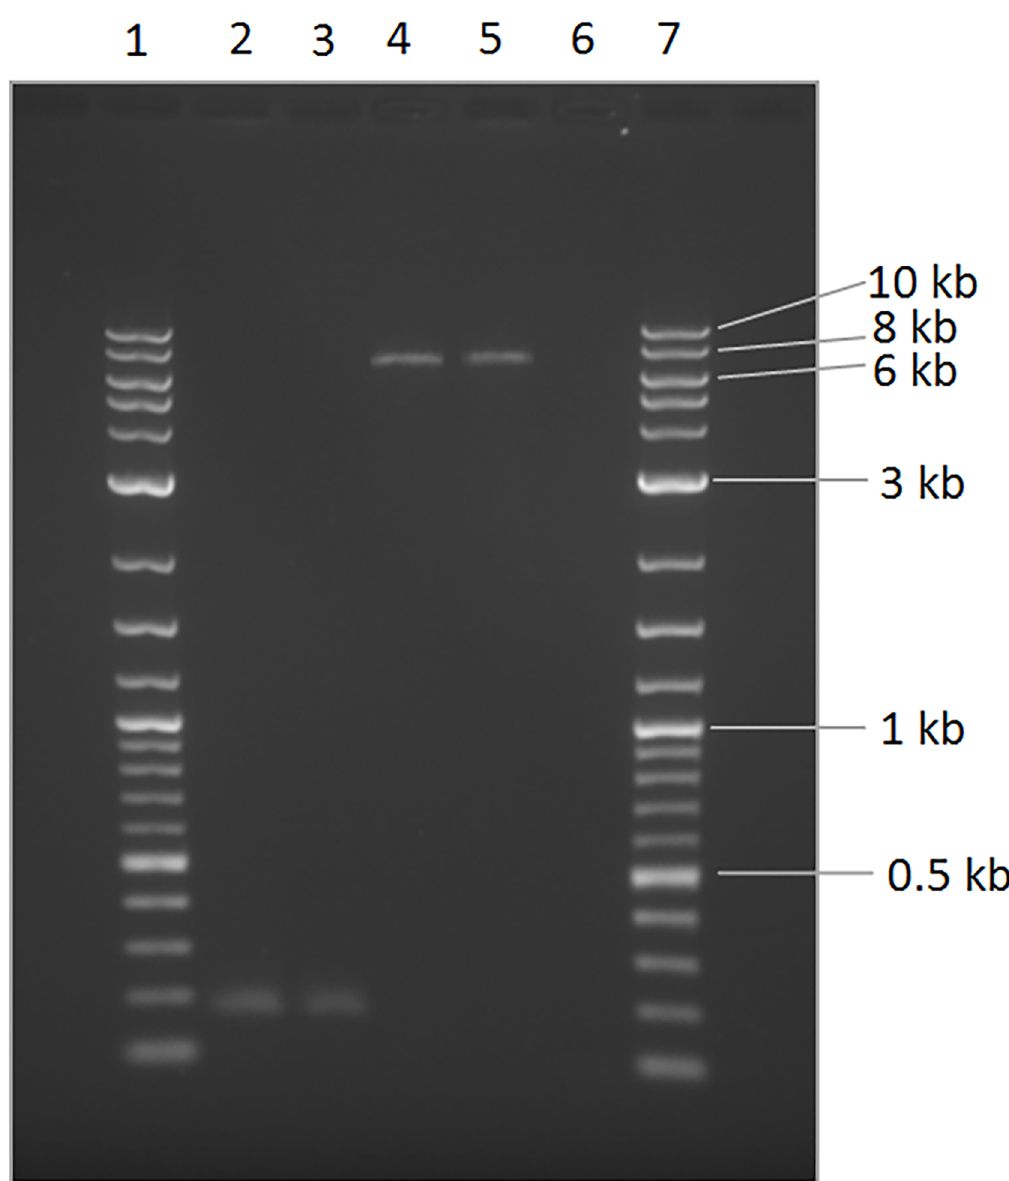
Fig 2. Agarose gel electrophoresis analysis of PCR amplification of the LINE-1 insertion in UK Swedish Vallhund retinopathy cases and controls. Lanes1 and 7 are a 2-Log DNA ladder(New EnglandBiolabs, Hitchin, UK); Lanes2 and 3 are controls negativefor the LINE-1 insertion; Lanes4 and 5 are cases positive for the insertion; Lane 6 is a non-template